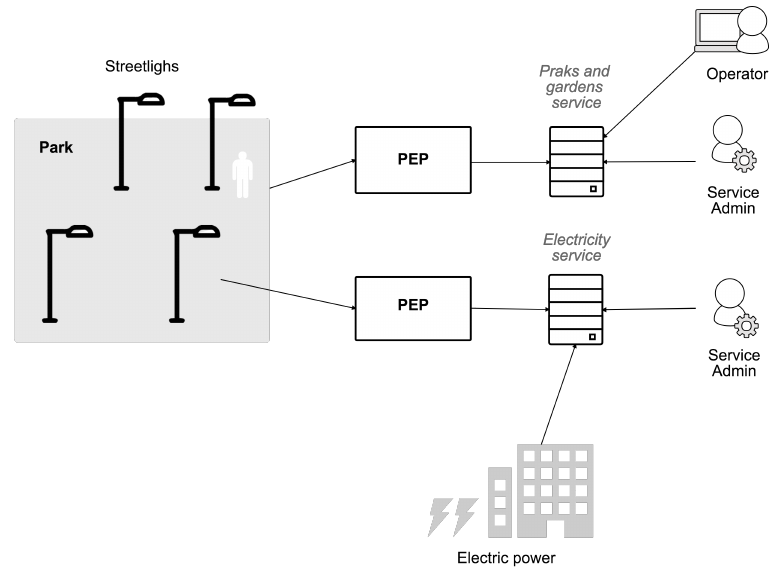
Figure 5. Smart city